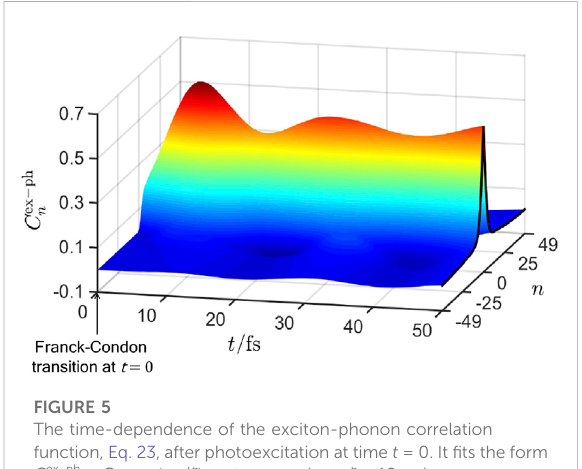
FIGURE 5 The time-dependence of the exciton-phonon correlation function, Eq. 23, after photoexcitation at time t = 0. It fi ts the form C ex − ph (cid:2) C (− n / ξ ) as t → ∞ , where ξ ~ 10. n is a monomer n 0 exp index. The vibrational period is 20 fs. FIGURE 6